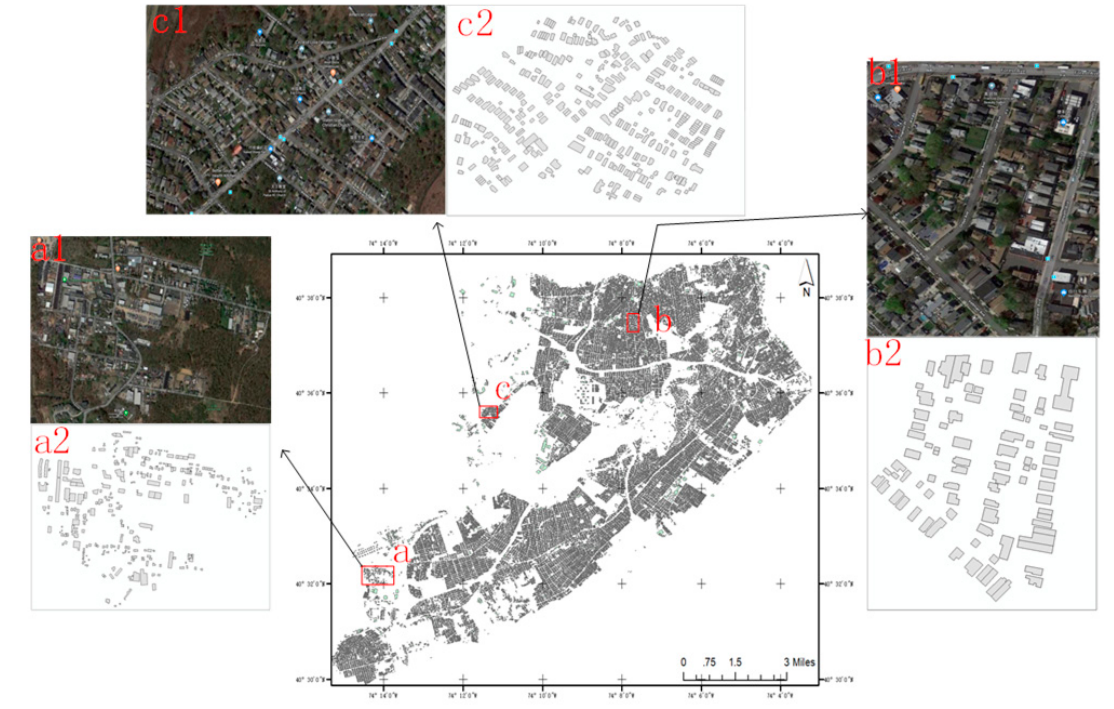
Figure 5. Case study regions. a1, a2, b1, b2, c1, and c2 are Google maps and GIS vector maps corresponding to regions a , b, and c, respectively.